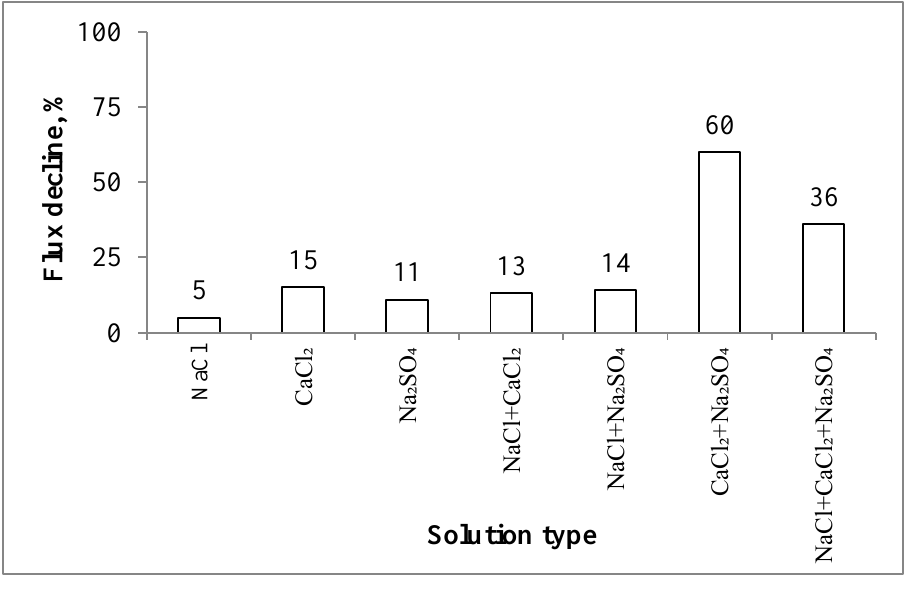
Figure 3. Normalized water flux profiles during the filtration of ( a ) single salt and ( b ) mix of two salts. Experimental conditions: concentrations of NaCl, CaCl 2 , and Na 2 SO 4 are 1.754, 6.132, and 4.487 g / L, respectively; 12.5 cm / s cross-flow velocity; the feed and draw solutions were circulated counter-currently; and an AL-FS orientation.